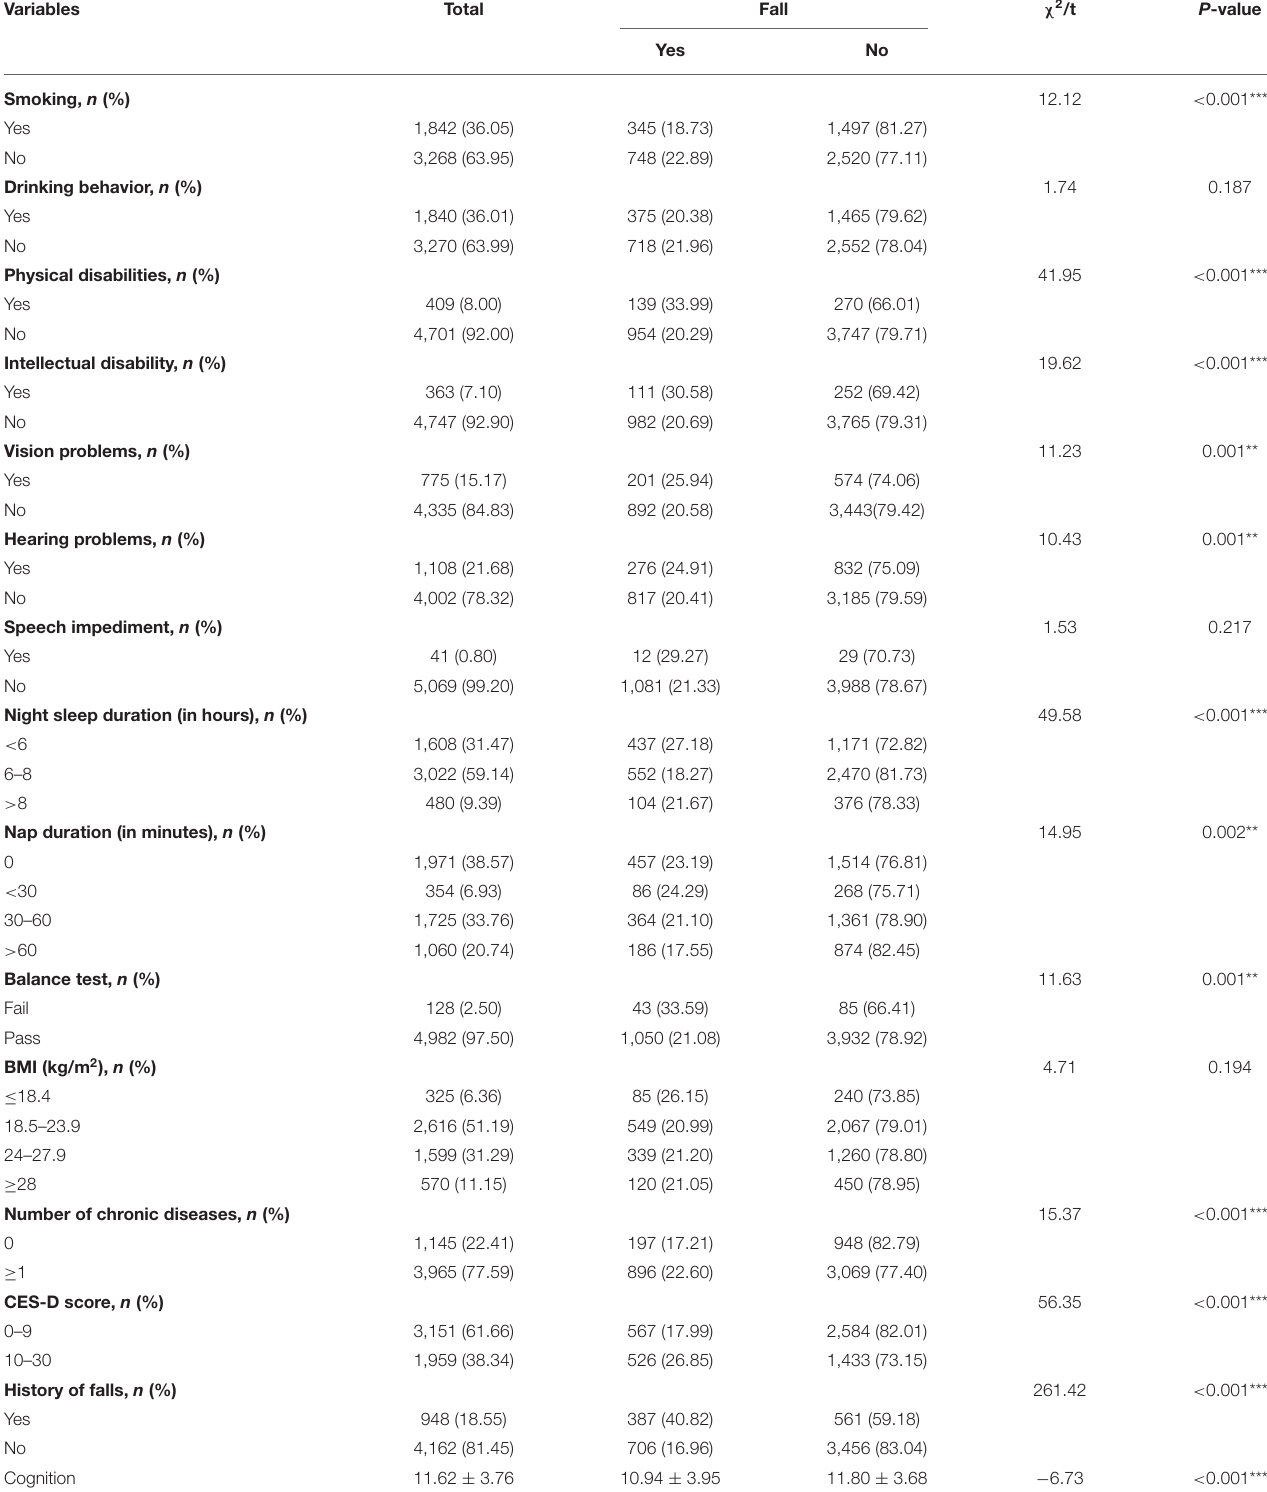
TABLE 2 | Comparison of controlled variables between the non-fallers group and the fallers group ( n = 5,110). Variables Total